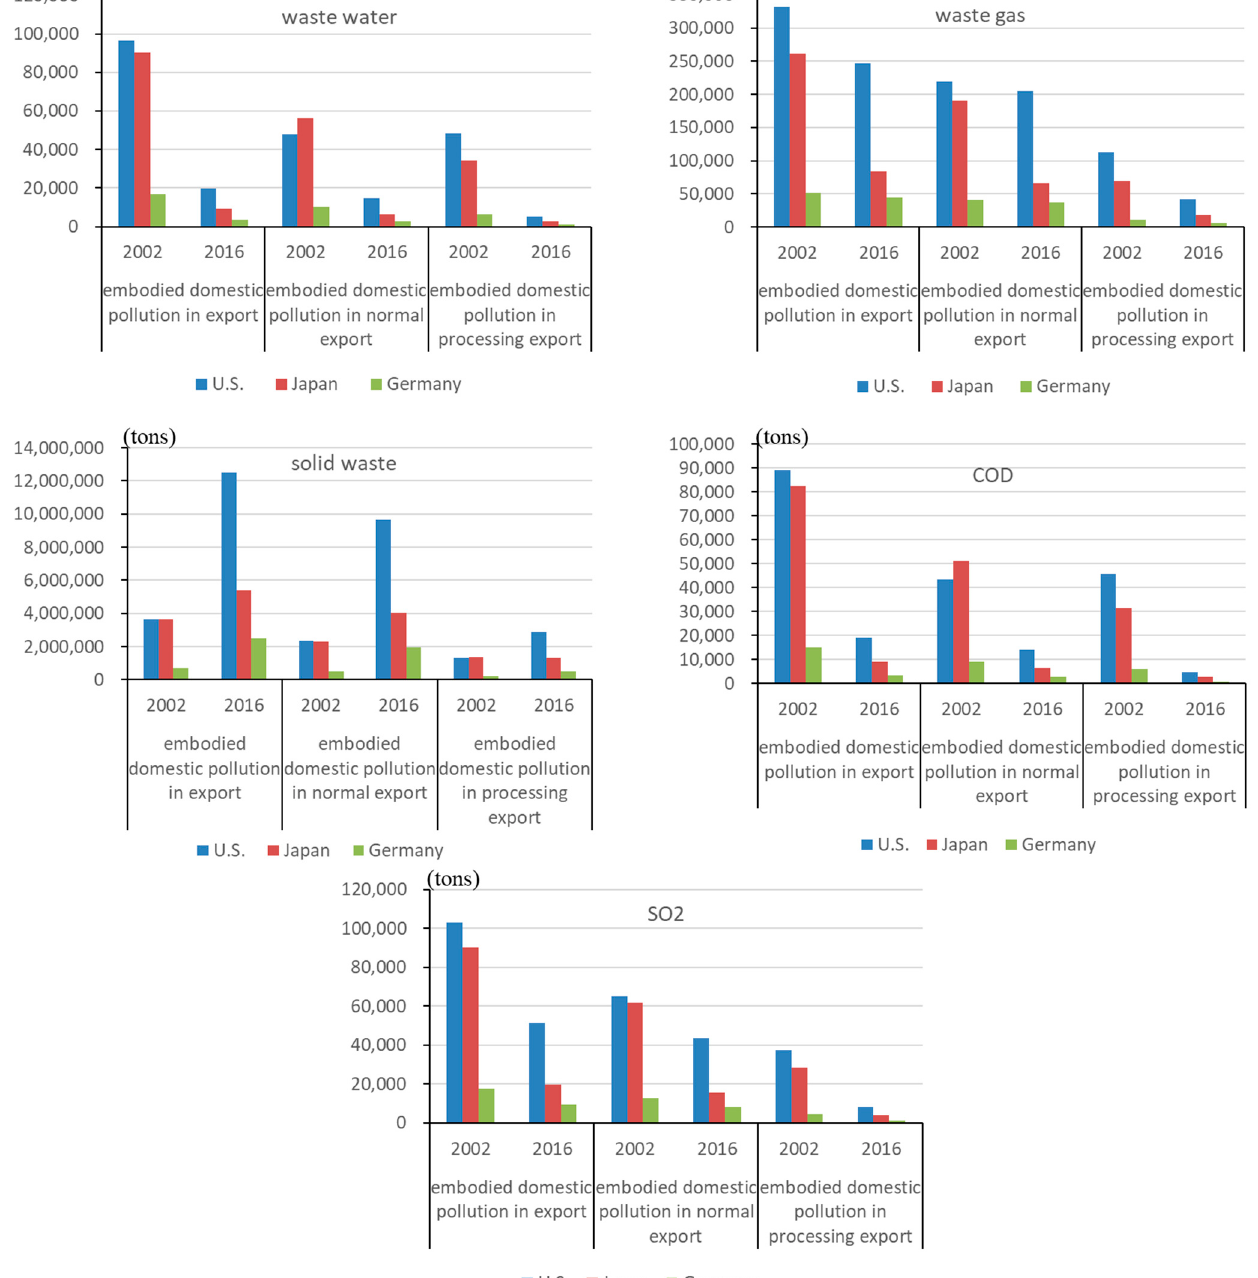
Figure 2. The embodied domestic emission in China’s exports to the US, Japan, and Germany (unit: tons).